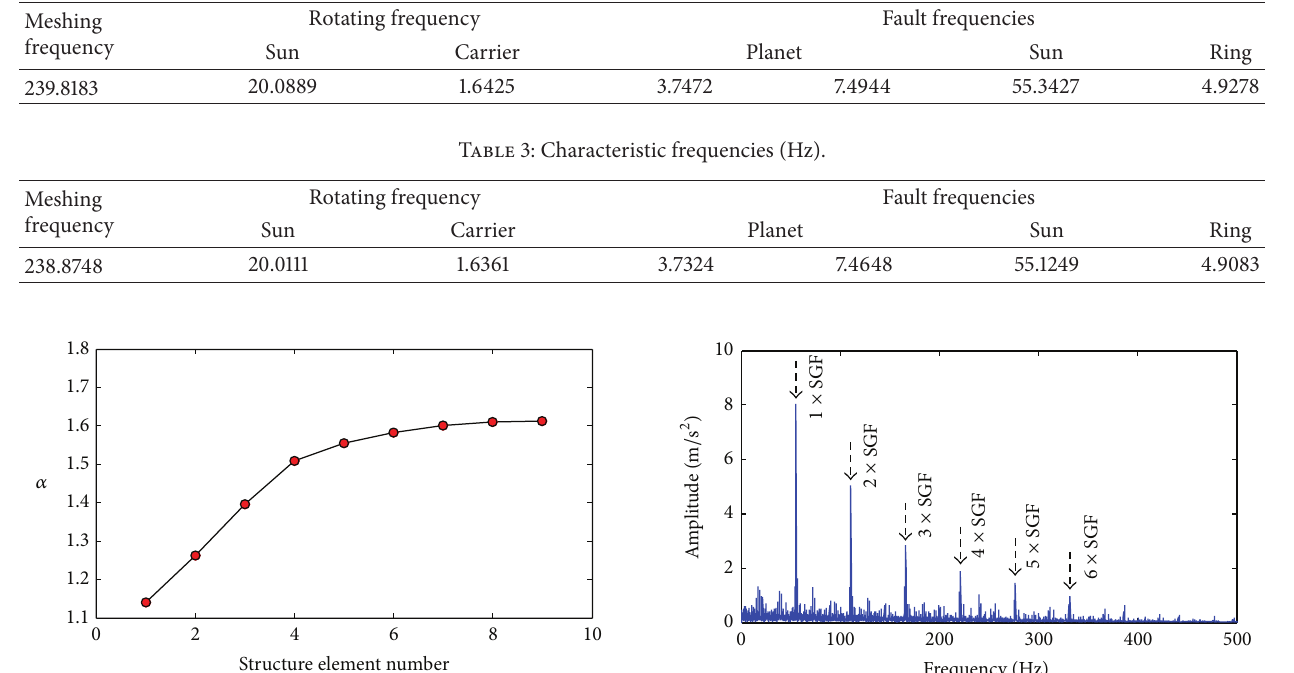
Figure 27: Frequency spectrum of filtered